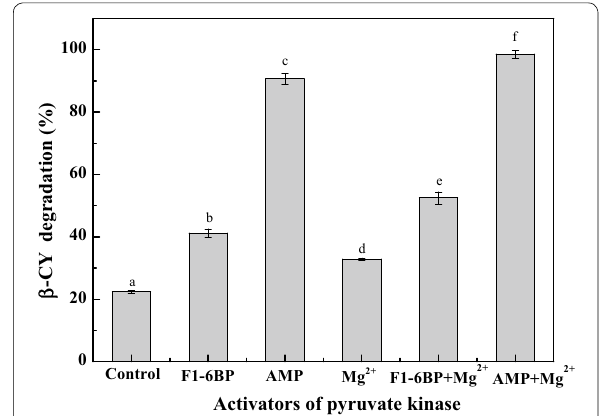
Fig. 2 Effects of pyruvate kinase activators on co-metabolic degradation of β-CY by strain B-1. Data are presented as mean standard deviation of three replicates; the standard ± deviations are within 5% of the mean. Different letters indicate significant differences ( p <